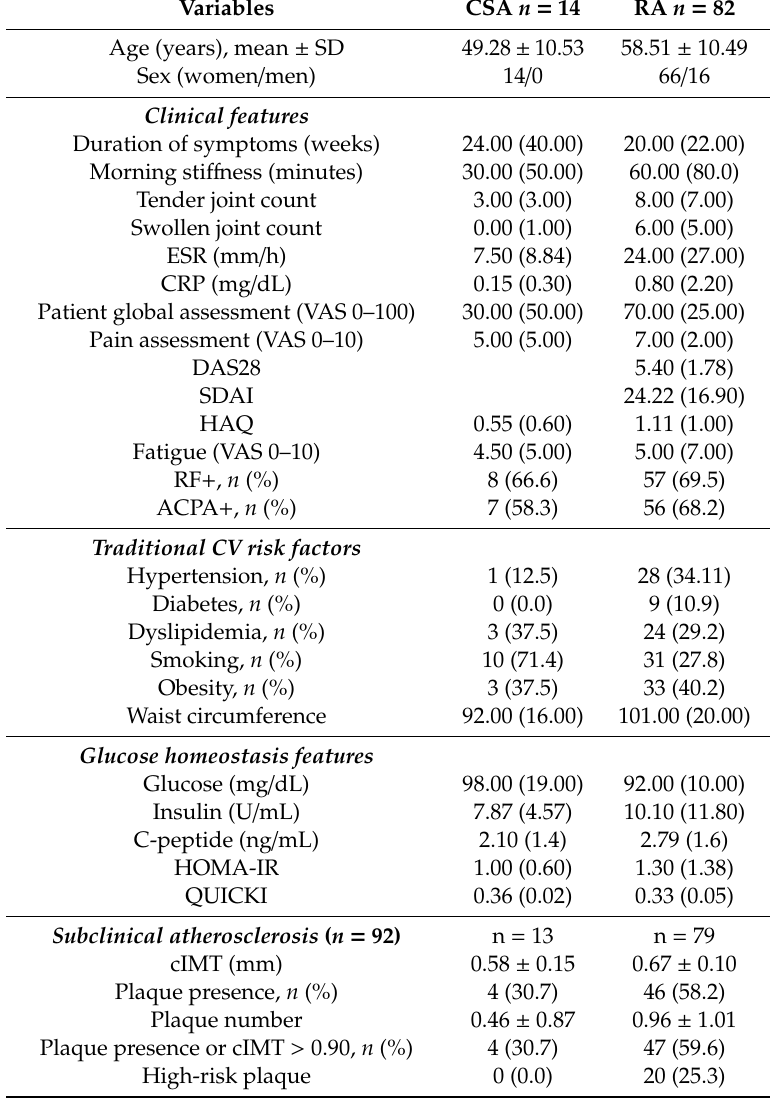
Table 1. Demographic, clinical, and subclinical atherosclerosis assessments in rheumatoid arthritis (RA) and clinically-suspect arthralgia